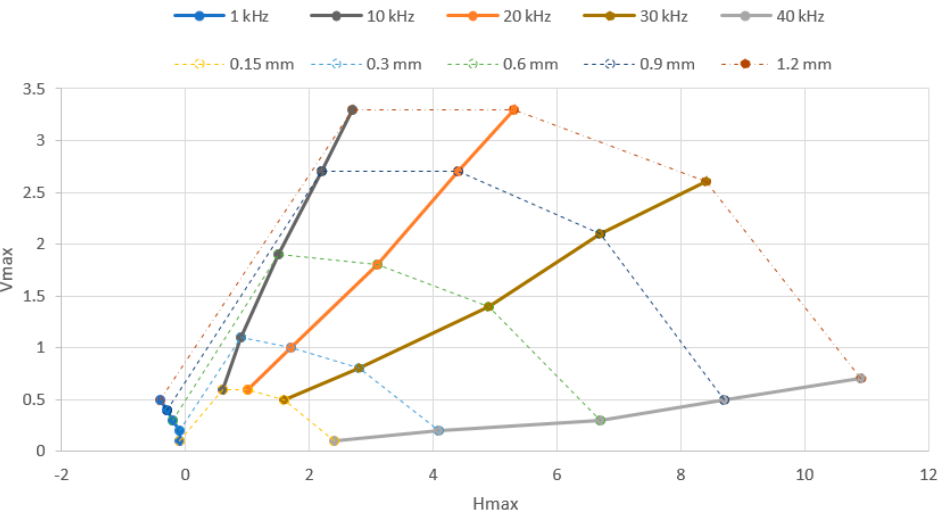
Figure 7. Lift-off effect diagram (P2 probe).